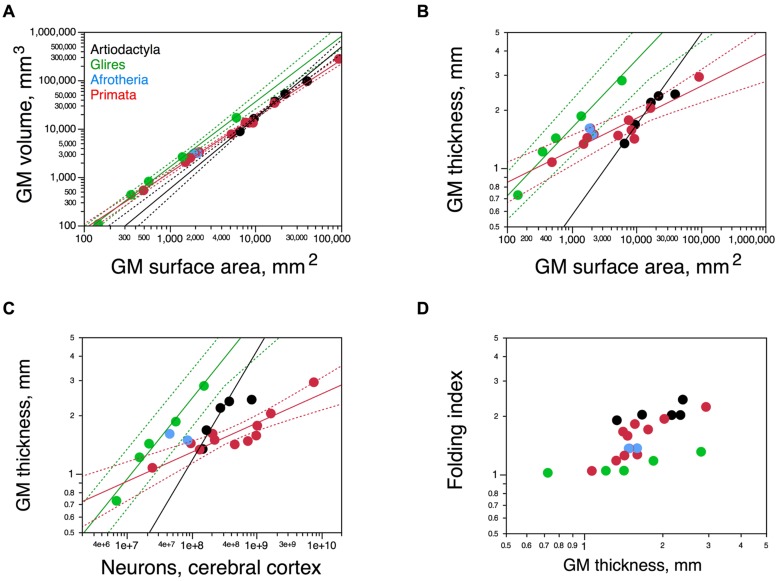
Scaling of the cortical gray matter. (A) Variation in the volume of the cortical gray matter as a function of the total surface area of the gray matter. Power functions for artiodactyls (minus the giraffe), rodents, and primates are plotted and have exponents 1.466 ± 0.036, 1.350 ± 0.037, and 1.165 ± 0.026, respectively. Notice that the artiodactyl cortex has a larger surface area than rodents for a similar gray matter volume. (B) Variation in the thickness of the cortical gray matter as a function of the total surface area of the gray matter. Power functions for artiodactyls (minus the giraffe), rodents, and primates are plotted and have exponents 0.466 ± 0.036, 0.350 ± 0.037, and 0.165 ± 0.026, respectively. For a similar surface area, the artiodactyl cortex is thinner than the rodent cortex. (C) Variation in the thickness of the cortical gray matter as a function of the total number of cortical neurons. Power functions for artiodactyls (minus the giraffe), rodents, and primates are plotted and have exponents 0.562 ± 0.118, 0.413 ± 0.040, and 0.149 ± 0.024, respectively. Again, for a similar number of cortical neurons, the artiodactyl cortex is thinner than the rodent cortex. (D) FI of the cerebral cortex plotted as a function of the average thickness of the cortical gray matter. Notice that for similar cortical thicknesses, both the artiodactyl and the primate cortex are more folded than the rodent cortex. Artiodactyls in black, afrotherians in blue, glires in green, primates in red. Data from Azevedo et al. (2009), Herculano-Houzel et al. (2010), Ribeiro et al. (2013), Ventura-Antunes et al. (2013), and Neves et al. (2014).